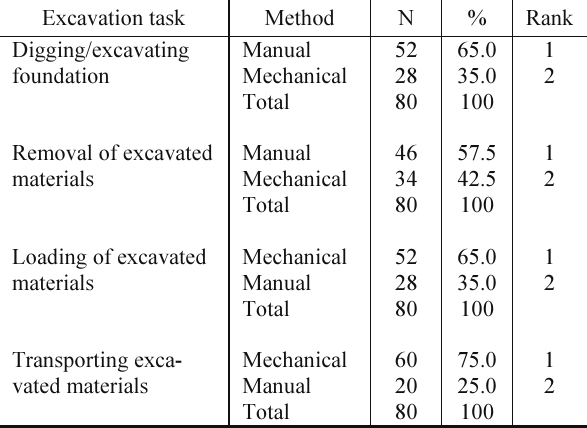
Table 1. Levels of mechanization of tasks in excavation operation Excavation task